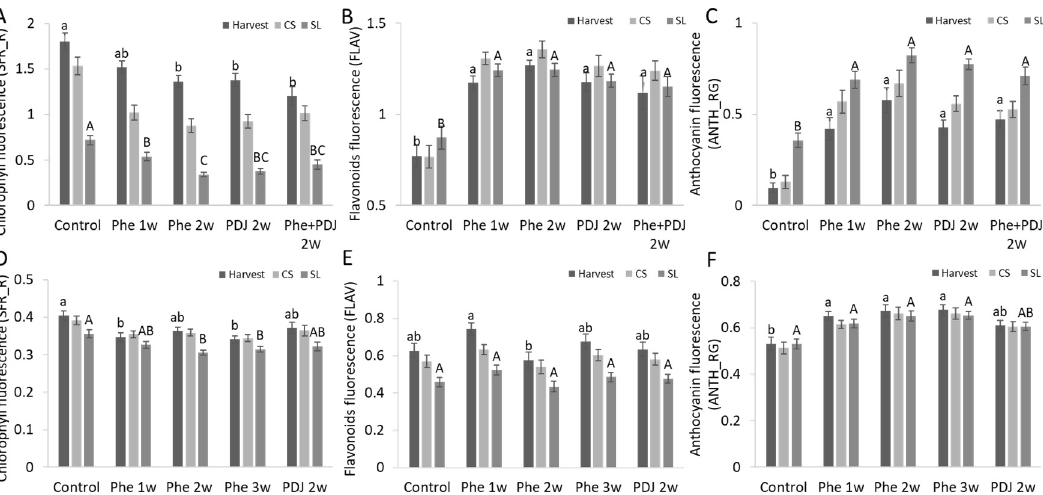
Figure 4. Effect of preharvest treatment of Phe and PDJ on chlorophyll, anthocyanin, and flavonoids fluorescence. Mango (cv. Kent, A − C ) and apple (cv. Cripps pink, D − F ) orchards were treated 1 − 3 weeks (1W, 2W, 3W) preharvest with 0.12% Phe or 0.2% PDJ and chlorophyll, anthocyanin, and flavonoids fluorescence at the reddest point of the fruit peel was analyzed at 3-time points: after harvest, after cold storage (CS), and after shelf-life (SL). (A, D) Chlorophyll fluorescence (SFR_R). ( B,E ) Flavonoids fluorescence (FLAV). ( C,F ) Anthocyanin fluorescence (ANTH_RG). Mean values and standard errors are presented. Statistical analysis was conducted for each time point separately (small and capital letters). Different letters represent significant differences ( p ≤